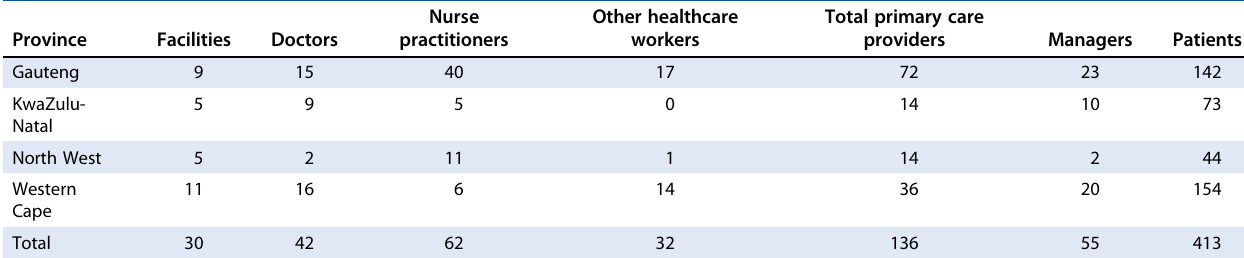
Table 2: Profile of the respondents